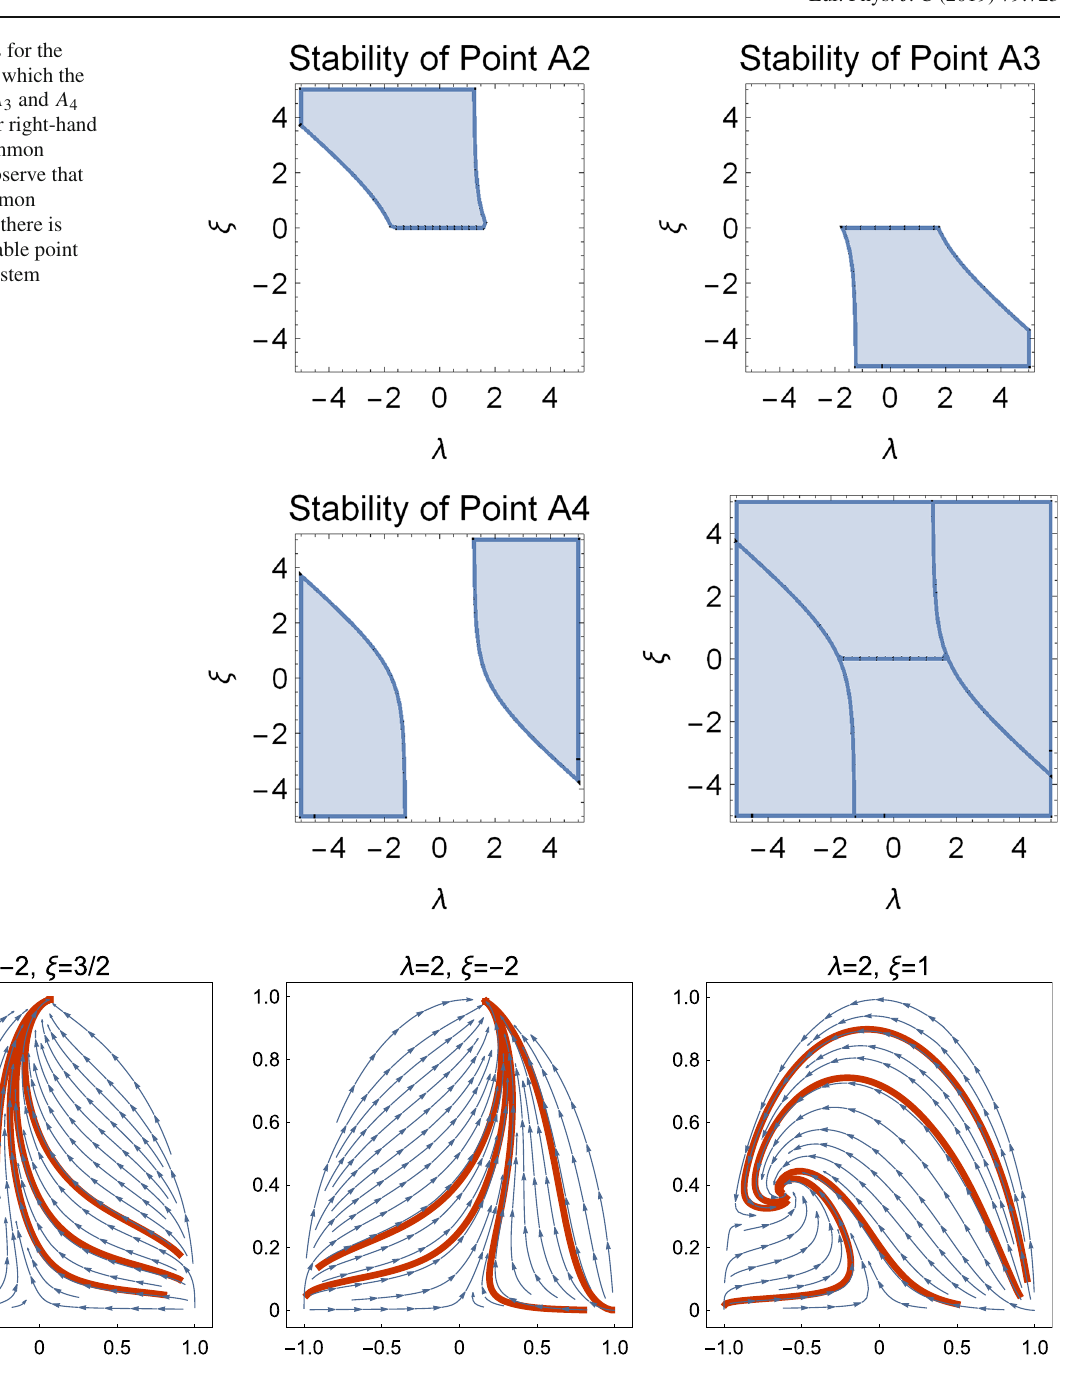
Fig. 7 Phase space diagrams for the dynamical system (20), (21) with three different sets of the free parameters λ,ξ where one of the critical points ¯ A 2 , ¯ A 3 and ¯ A 4 is stable. For (λ,ξ) =